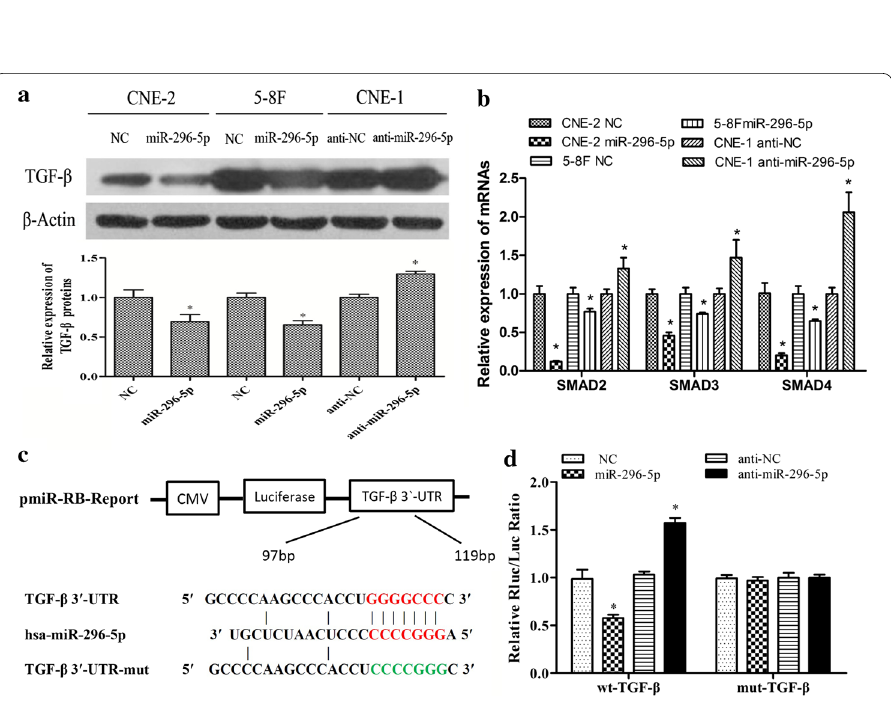
Fig. 4 MiR296-5p suppresses TGF-β expression by directly targeting its 3 ʹ -UTR. a Western blotting showed miR-296-5p expression inversely affected TGF-β expression in NPC cells. b Real-time PCR showed that miR-296-5p expression affected the downstream gene expression of TGF-β in NPC cells. c The binding sites of miR-296-5p with wild-type or mutant TGF-β in 3 ʹ -UTR. d Luciferase assays in 293T cells treated with both wild-type or mutant TGF-β vectors along with an miR-296-5p mimic, inhibitor or relevant